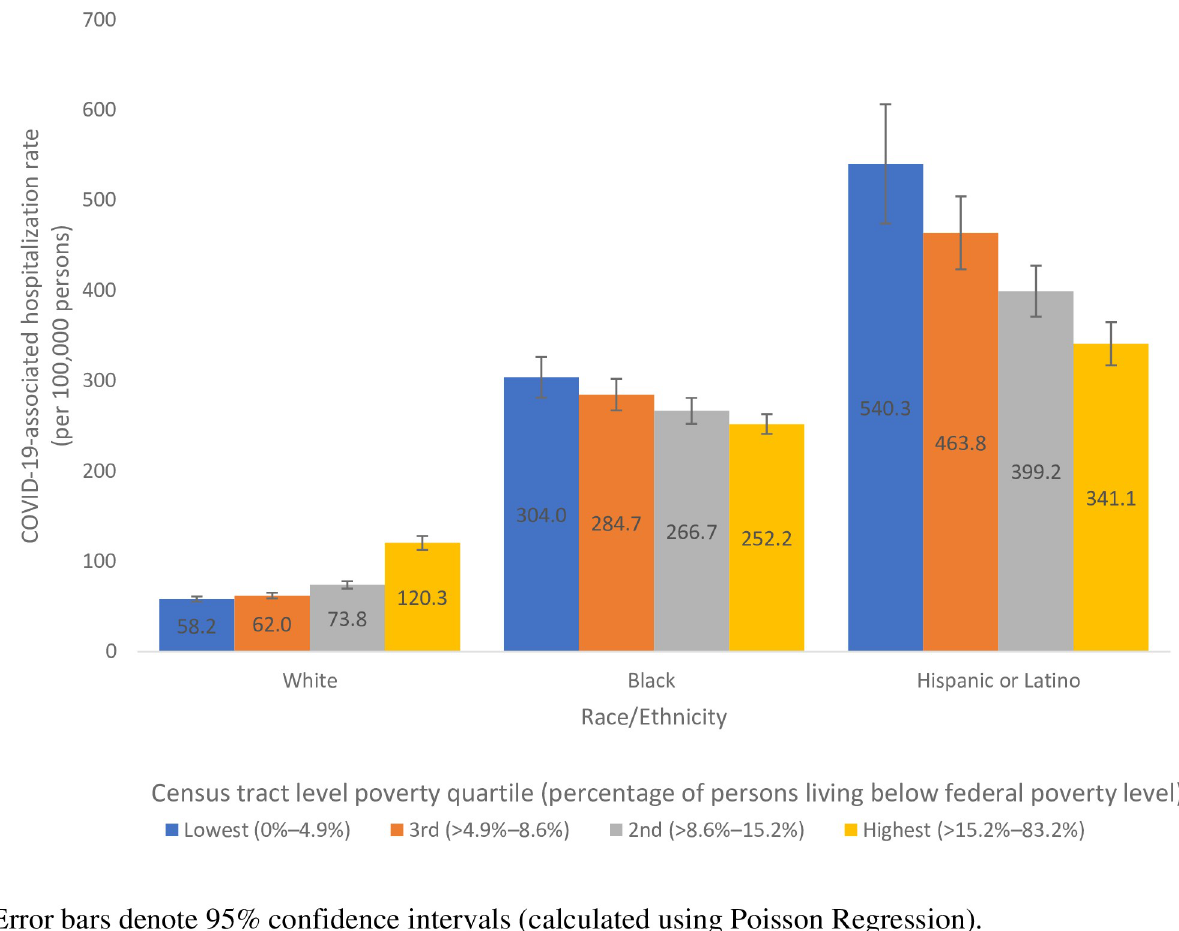
Fig 2. Age adjusted COVID-19-associated hospitalization rates by census tract-level poverty strata (quartiles) and race/ethnicity—COVID-NET catchment areas in 14 states, March–April 2020.